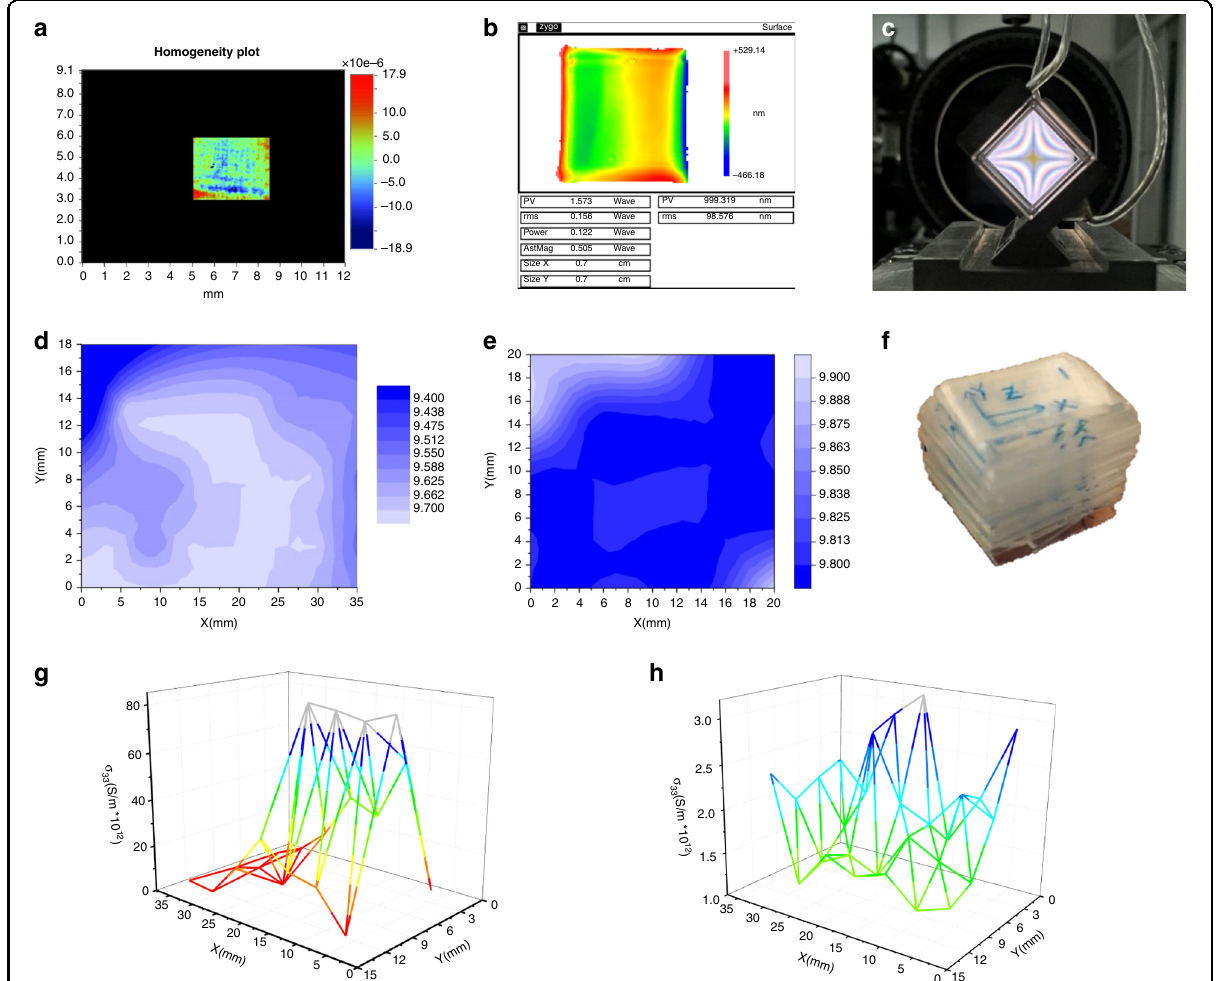
Fig. 10 Homogeneity of H-KTP. Optical Homogeneity of H-KTP ( a ) and H-RKTP ( b ); c Conoscopic interference image of a H-RKTP EO switch. Piezoelectric coef fi cient d 33 distribution of d H-KTP and e H-RKTP; f 20 wafers with a thickness of 1 mm along the z -plane from beginning to end for con fi rming the ferroelectric domain of the crystal by measuring the piezoelectric coef fi cient d 33 ; Distribution of DC conductivity at 70 °C of